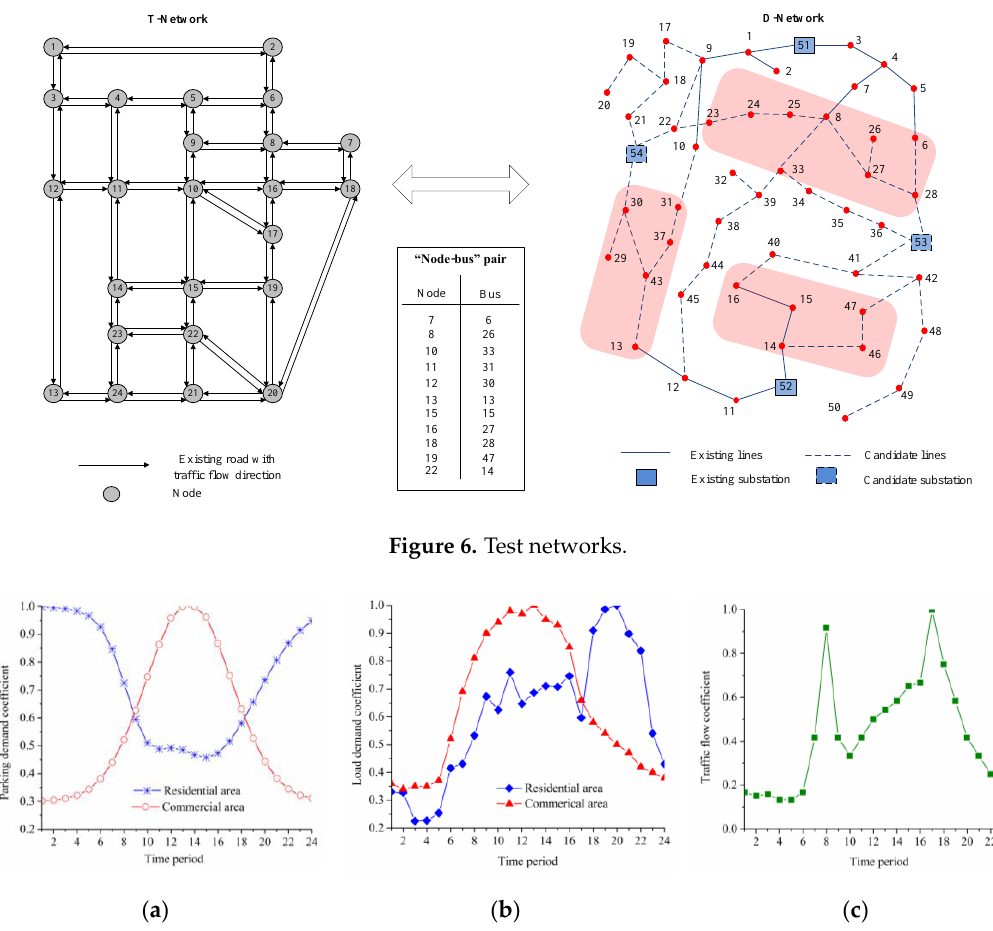
Figure 7. Typical normalized time curve. ( a ) Typical normalized daily parking demand time curve; ( b ) Typical normalized daily load demand time curve; ( c ) Typical normalized daily traffic flow coefficient time curve.